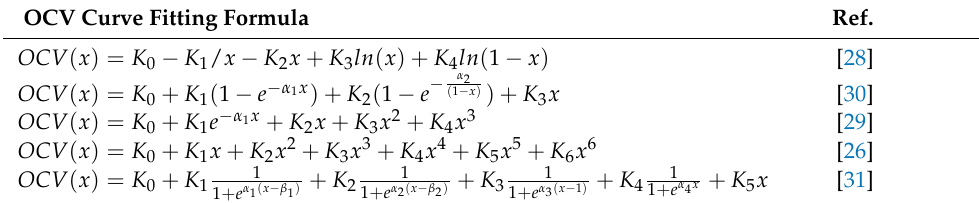
Table 1. Overview of OCV models. OCV Curve Fitting Formula